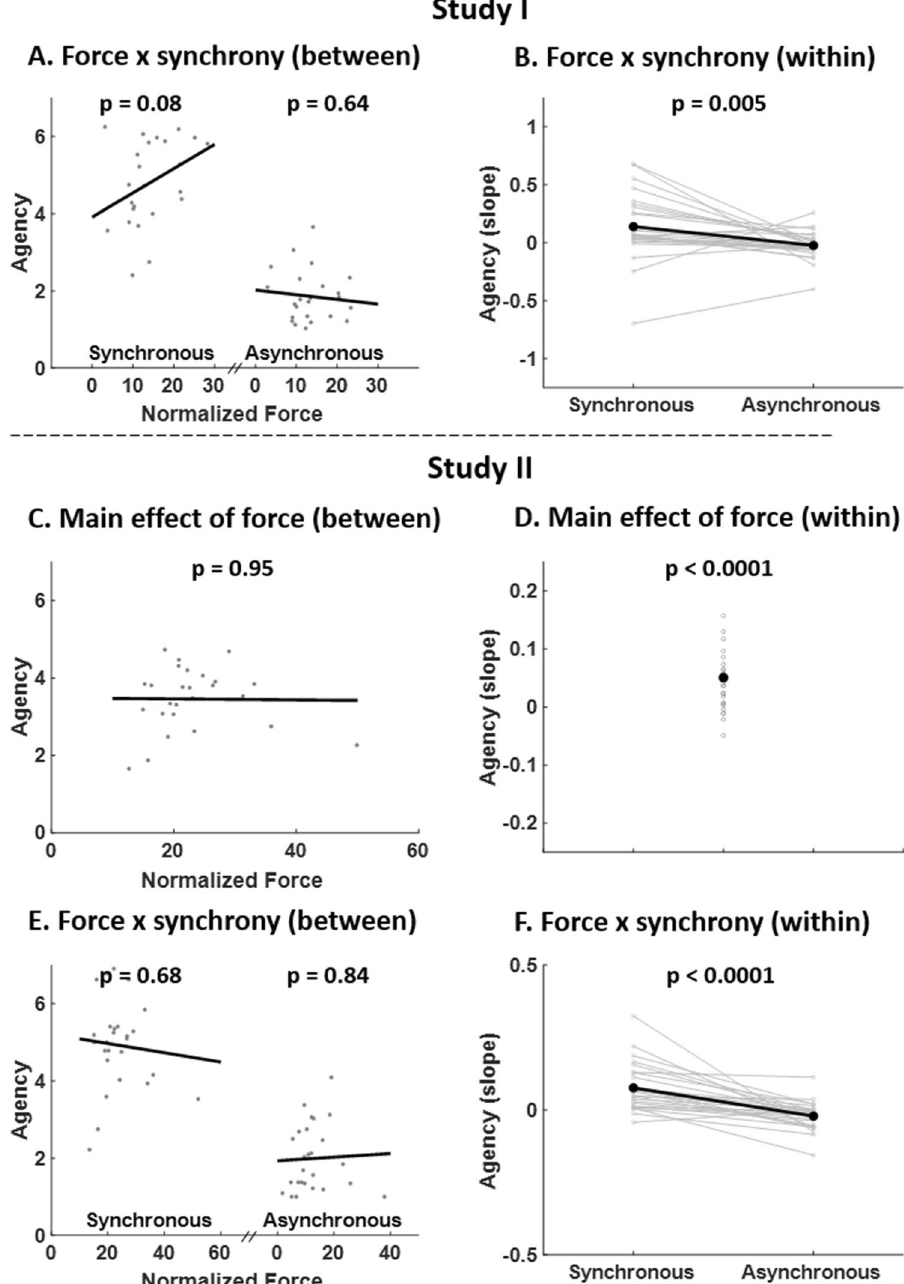
Figure 5. SA ratings - post-hoc comparisons for main effect of “force” and interaction “force x synchrony” (Studies I and II). ( A–E ) Between-subject regressions between SA ratings and force for synchronous conditions (left) and asynchronous conditions (right) are shown. Grey data points correspond to the mean SA rating and mean force across synchronous/ asynchronous trials for each subject. The black lines correspond to the between-subject regression line. The non-significant regressions suggest that the interactions “force x synchrony” (Table 1, Studies I and II) are not explained by between-subject variability. ( B–F ) Within-subject regression coefficients between SA ratings and force for synchronous conditions (left) and asynchronous conditions (right) are shown. For each subject, a regression between SA ratings and force for all synchronous/ asynchronous trials was computed and a paired t-test was computed between the synchronous and asynchronous regression coefficients. Data points plotted in grey correspond to individual regression coefficients and data points plotted in black represent the mean coefficients across subjects. The significant paired t-tests suggest that the interactions “force x synchrony” (Table 1, Studies I and II) are explained by within-subject variability. ( C ) Post-hoc comparisons as in A-E to evaluate the contribution of between-subject variability to the main effect of force. The non-significant regression suggests that the main effect of force (Table 1, Study II) is not explained by between-subject variability. ( D ) Post-hoc comparisons as in ( B – F ) to evaluate the contribution of within-subject variability to the main effect of force. The significant one sample t-test suggests that the main effect of force (Table 1, Study II) is explained by within-subject